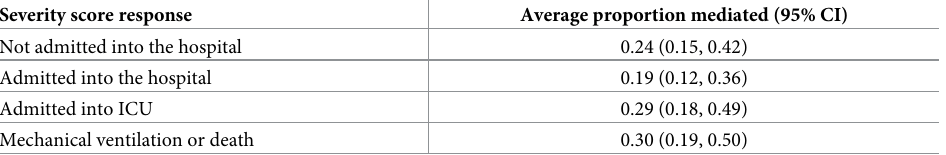
Table 3. Proportion of the association between obesity and disease severity mediated by diabetes in participants age < 65